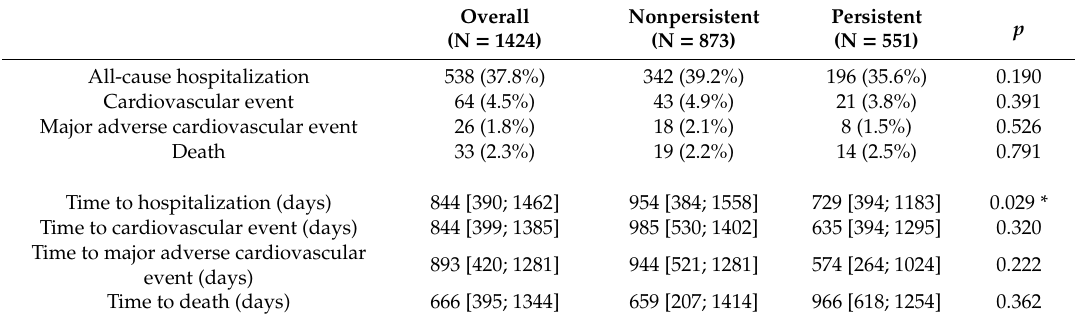
Table 2. Morbimortality and time to event in new male users of lipid-lowering drugs for primary cardiovascular disease prevention: overall and stratified by persistence.